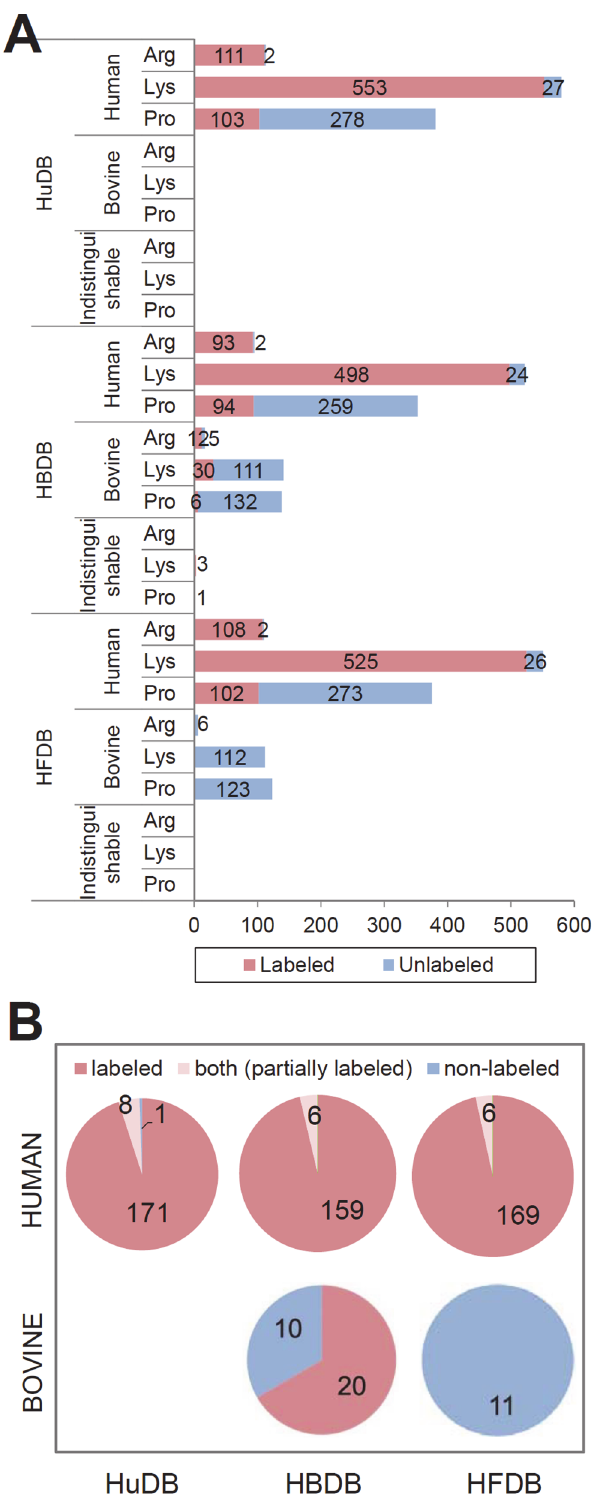
Fig 4. Search results of MS/MS data from SILAC-labeled secretome of HCT-116. (A) Mass spectrometric data were searched against HuDB, HBDB and HFDB databases, and then arginine, lysine, and proline residues in all PSMs were counted and classified into isotope-labeled (red) and unlabeled (blue) residues.